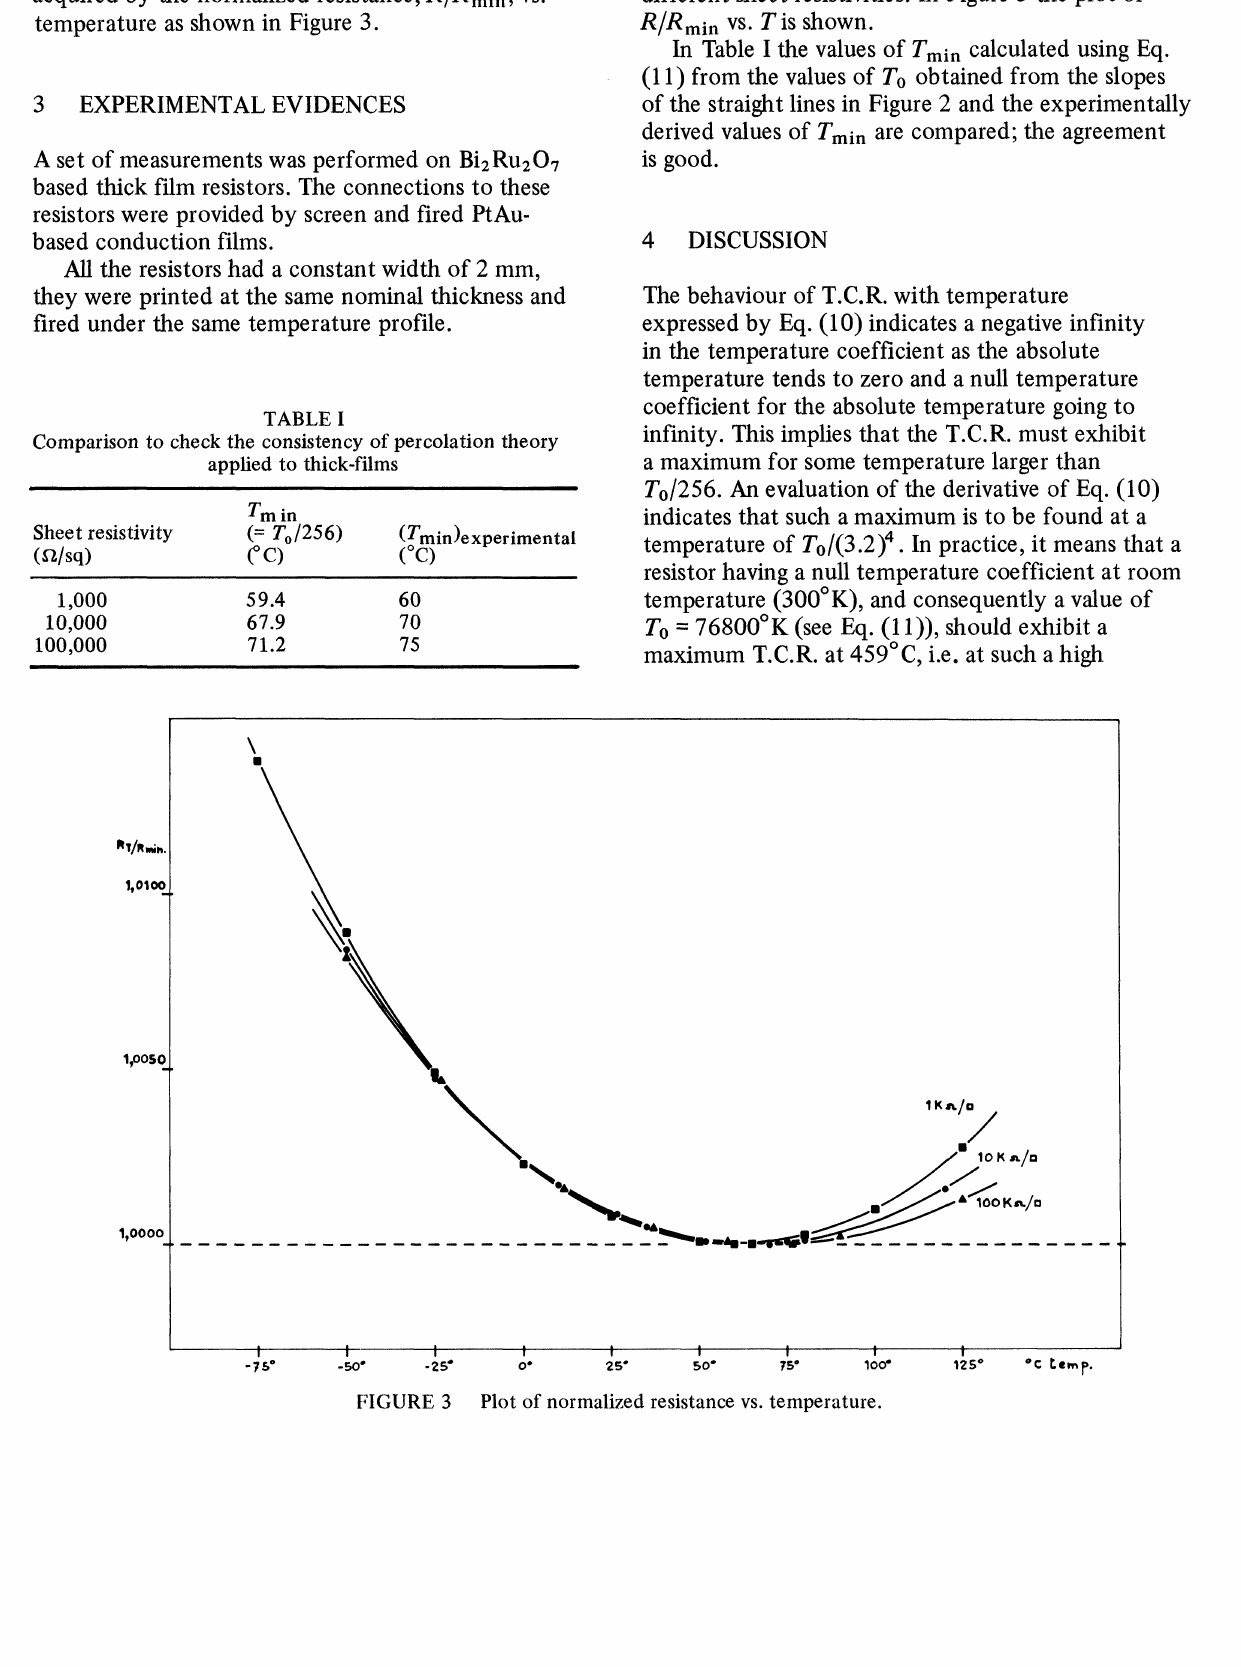
FIGURE 3 Plot of normalized resistance vs.